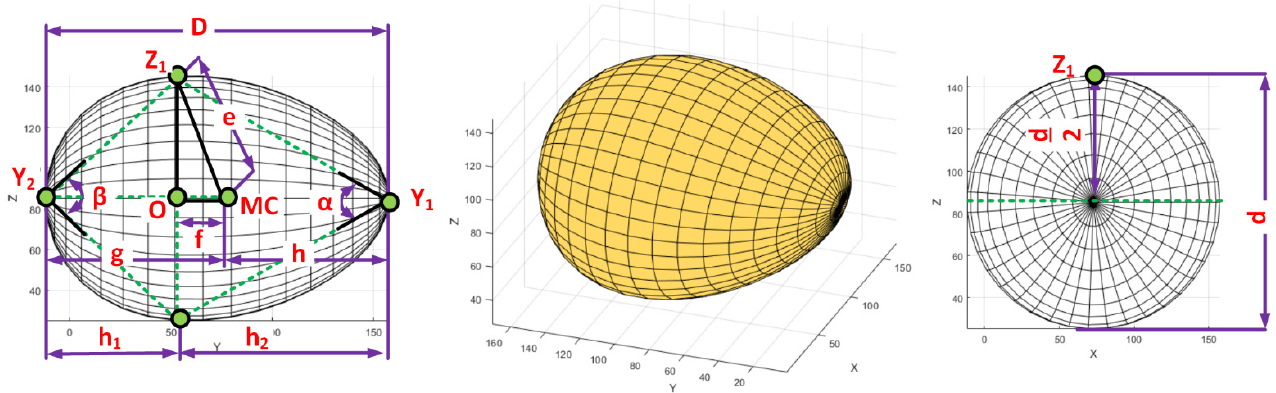
Figure 2. 3D egg model and parameters.